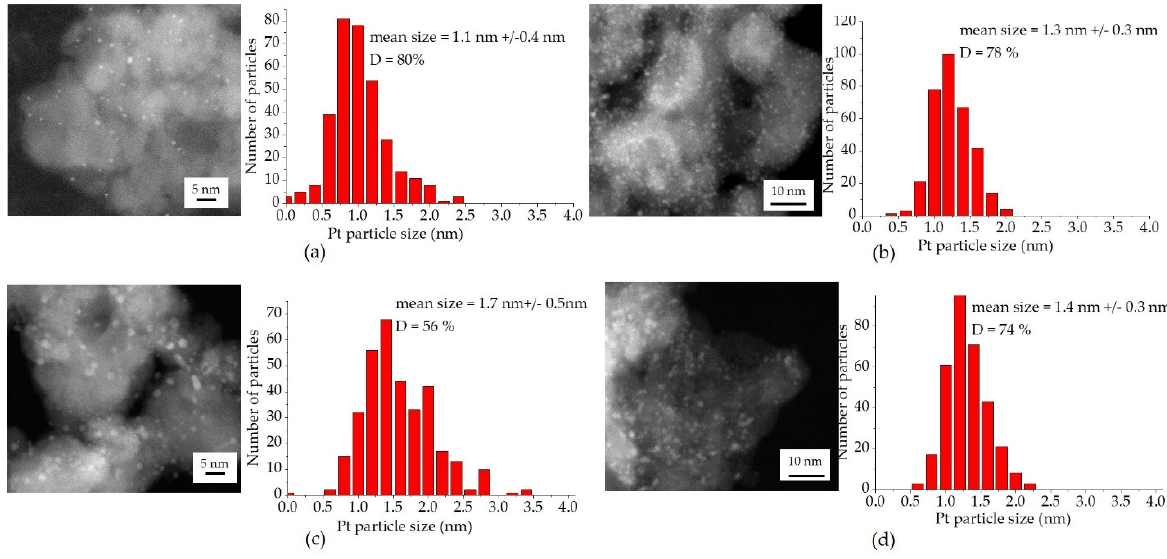
Figure 8. HAADF-STEM analysis of platinum-supported catalysts before and after CO oxidation. ( a , c ) Pt/SFO_cp before and after CO oxidation; ( b , d ) Pt/SFO_eaf before and after CO oxidation. Despite the low specific surface area of SFO_eaf, platinum is well-dispersed on the surface with a particle size of 1.3 +/ − 0.3 nm (Figure 8b). This particle size is also very sim- ilar to the one of Pt/SFO_cp before testing, with an average particle size of 1.1 +/- 0.4 nm (Figure 8a). The difference observed in the CO oxidation performance is thus due to the impact of the support, and not the Pt particle size. The spent catalysts show rather differ- ent behavior. For Pt/SFO_eaf (Figure 8d), the particle size is nearly unchanged when com- pared to the fresh samples (average particle size of 1.4 +/- 0.3 nm). In comparison, the particle size increases for Pt/SFO_cp from 1.1 +/- 0.4 nm to 1.7 +/- 0.5 nm (Figure 8c). The deactivation of Pt/SFO_cp upon cycling can thus be partially explained by the growth in Pt particle size. Again, we observe higher stability for the eaf-synthesized samples with respect to stability of the Pt-nanoparticles, but also the support materials. 3. Materials and Methods CaFeO 2.5 and SrFeO 2.5 were prepared by a recently described method [5] , herein called complexation method. Stoichiometric amounts of Ca(NO 3 ) 2 ·4H 2 O (Sigma-Aldrich, Stein- heim, Germany >99%) or Sr(NO 3 ) 2 (Alfa-Aesar, Kandel, Germany, >99%) and Fe(NO 3 ) 3 ·9H 2 O (Alfa Aesar, Kandel, Germany, >98%) were dissolved in water. Then, citric acid (Sigma-Aldrich, >99.5%) was added and the solution was stirred for 2 h. The molar ratio of citric acid to the total amount of cations was kept to one. The pH value was ad- justed to pH = 3 using 37% ammonia solution (Merck, Darmstadt, Germany, 28%), fol- lowed by the addition of ethylene glycol (Sigma-Aldrich, Saint-Louis, MO , USA, >99.8%). The solution was evaporated at 90 °C on a hot plate until jellification. The gel was then quickly fired at 400 °C in air to obtain a powder. The as-obtained powder was calcined by heating under atmosphere (synthetic air for CaFeO 2.5 and pure argon for SrFeO 2.5 ) at 2 °C/min up to 600 °C and kept for 6 h at this temperature. The powders were finally crushed in a mortar.